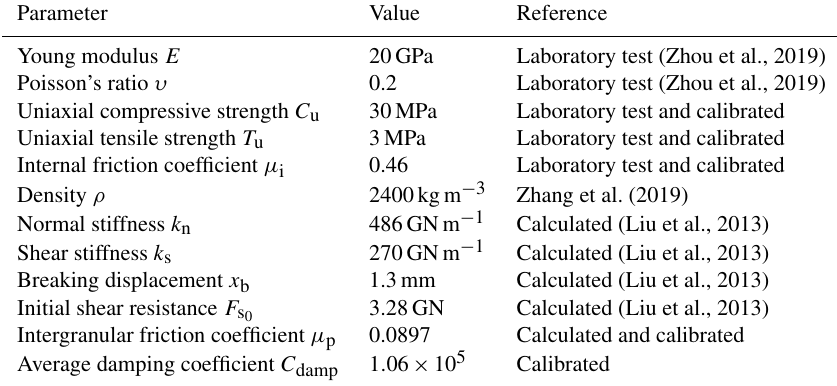
Table 1. Macro- and micro-mechanical parameters of Baige landslide material used in the discrete-element model.